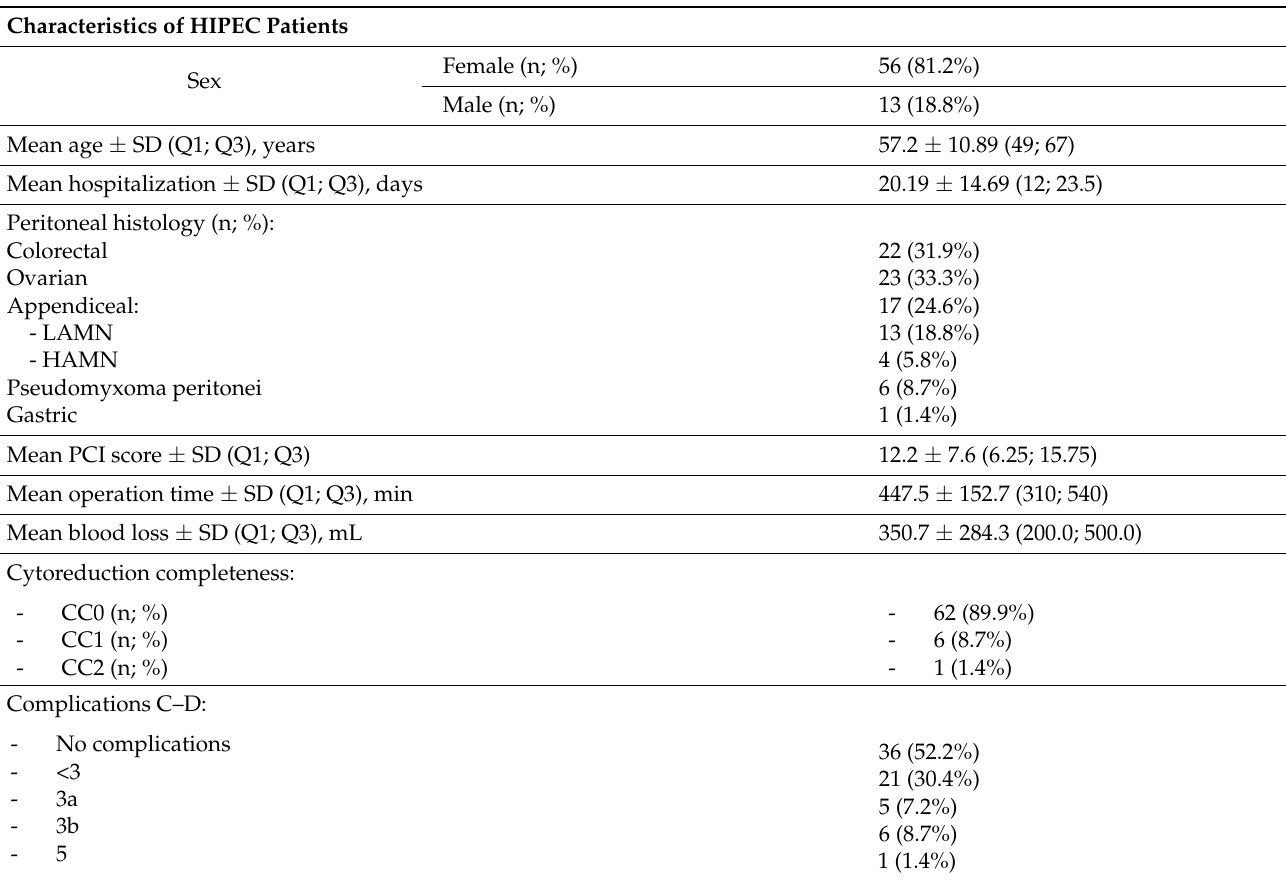
Table 1. Baseline clinicopathologic characteristics of patients who underwent cytoreductive surgery and hyperthermic intraperitoneal chemotherapy for peritoneal surface